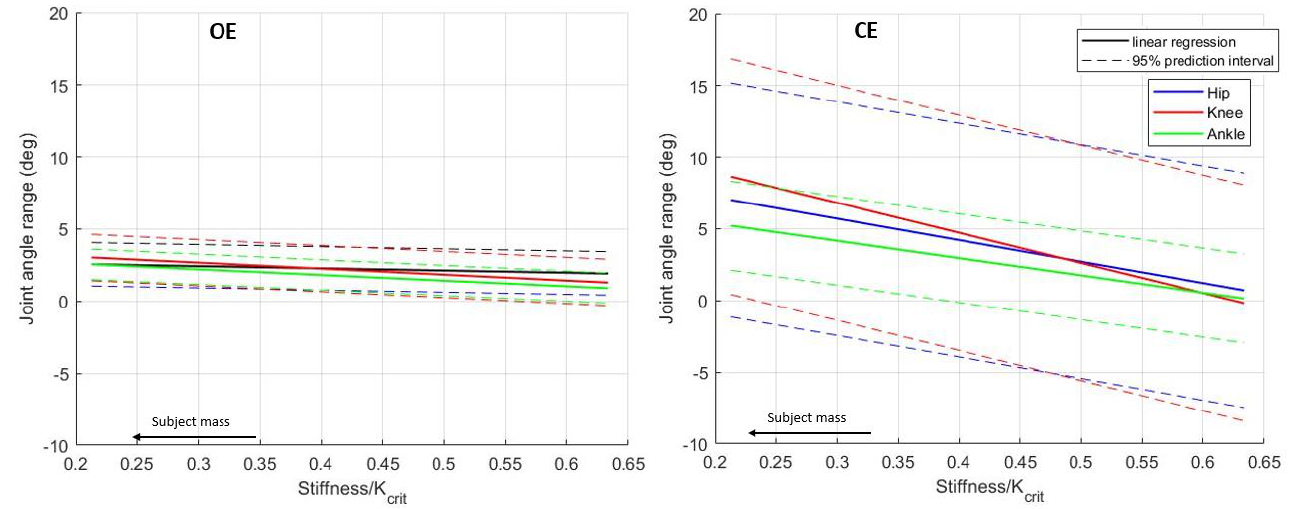
Figure 6. Linear regression of the joint angles ROM as a function of the normalized ankle stiffness in the OE ( left ) and CE ( right )